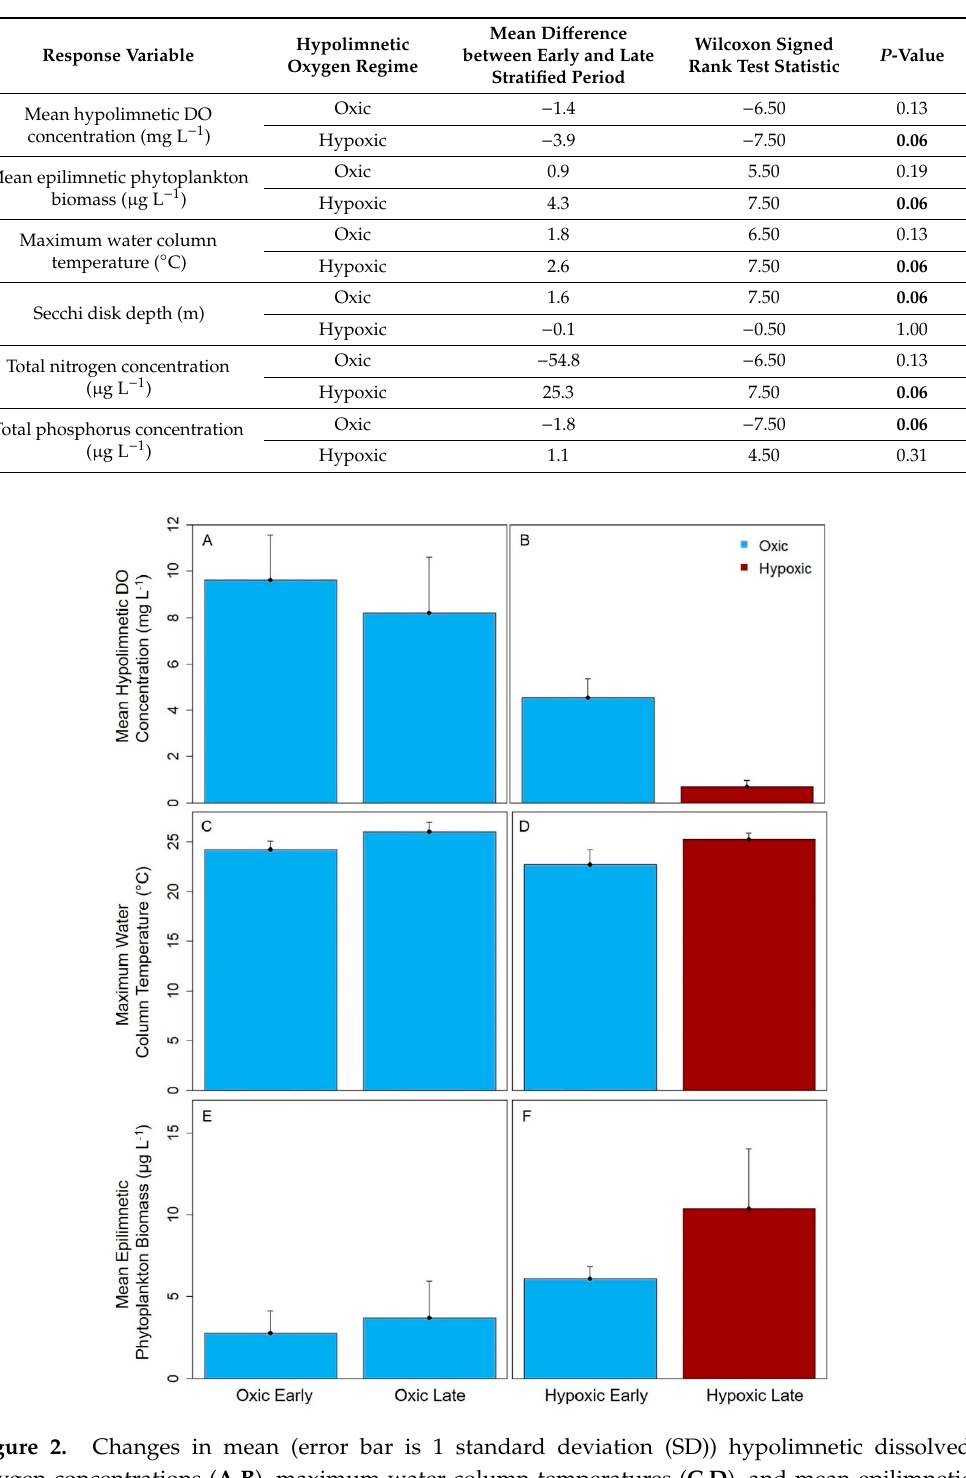
Table 2. Wilcoxon signed rank test statistics of the di ff erence in environmental variables between the early and late stratified periods of the reservoirs that remained oxic and the reservoirs that exhibited hypoxia in the late stratified periods across years. A positive di ff erence means that the value increased from the early to late stratified period. Bold P -values highlight statistically significant two-tailed P -values ( P < 0.10).